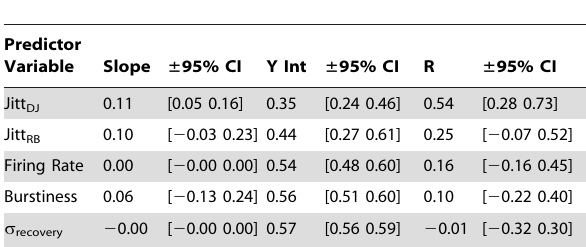
Table 1. Linear regression analysis on information rates.